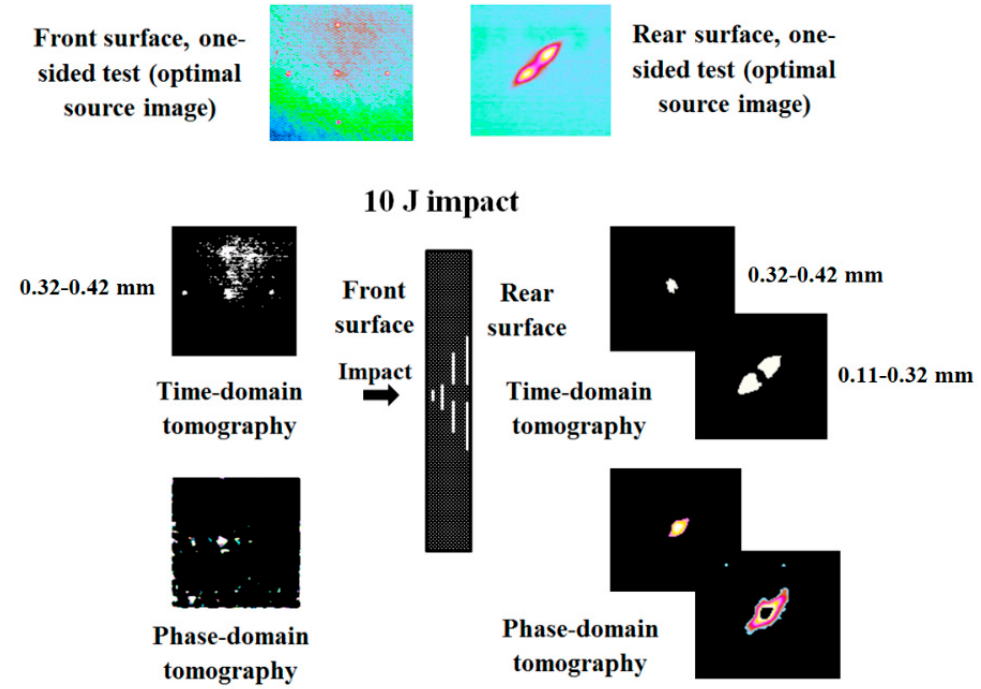
Figure 5. Time- and phase-domain thermal tomography of impact damage in 5 mm-thick CFRP sample (10 J impact energy).